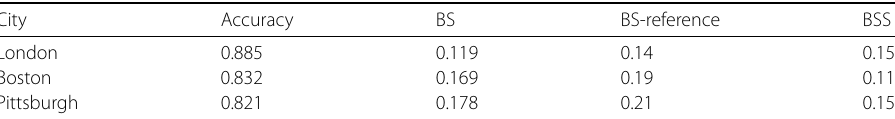
Table 5 Out-of-sample accuracy and Brier score for the different models City Accuracy BS BS-reference BSS London 0.885 0.119 0.14 0.15 Boston 0.832 0.169 0.19 0.11 Pittsburgh 0.821 0.178 0.21